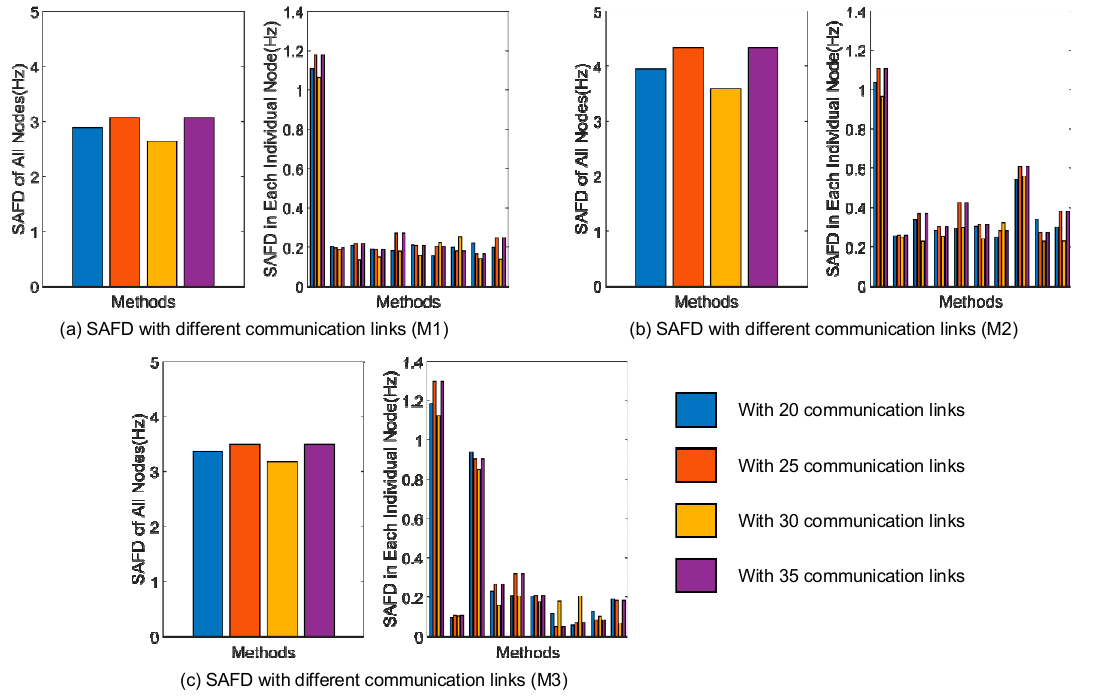
Figure 15. SAFD of all nodes and each individual node of the proposed method and the compared method with different numbers of communication links in frequency events F–H.